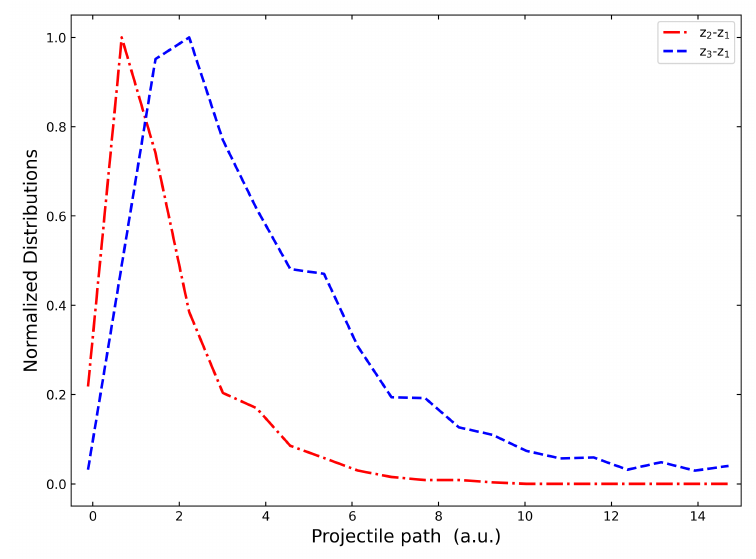
Figure 8. Histogram for the projectile path between the first and second electron removal ( z 2 − z 1 ) and the first and third electron removal ( z 3 − z 1 ) as predicted by the present Ad-CTMC